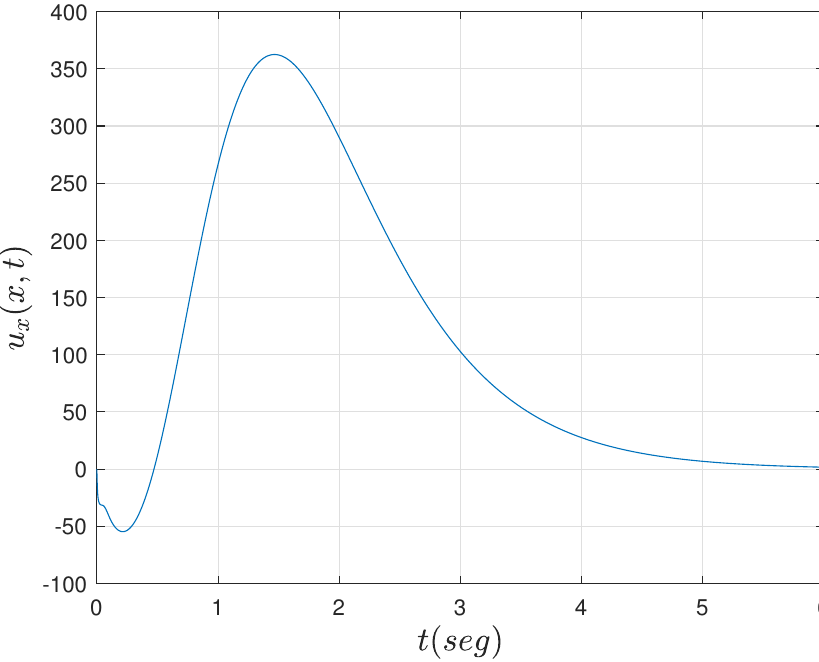
Figure 5. Control effort of the adaptive Neumann stabilizing